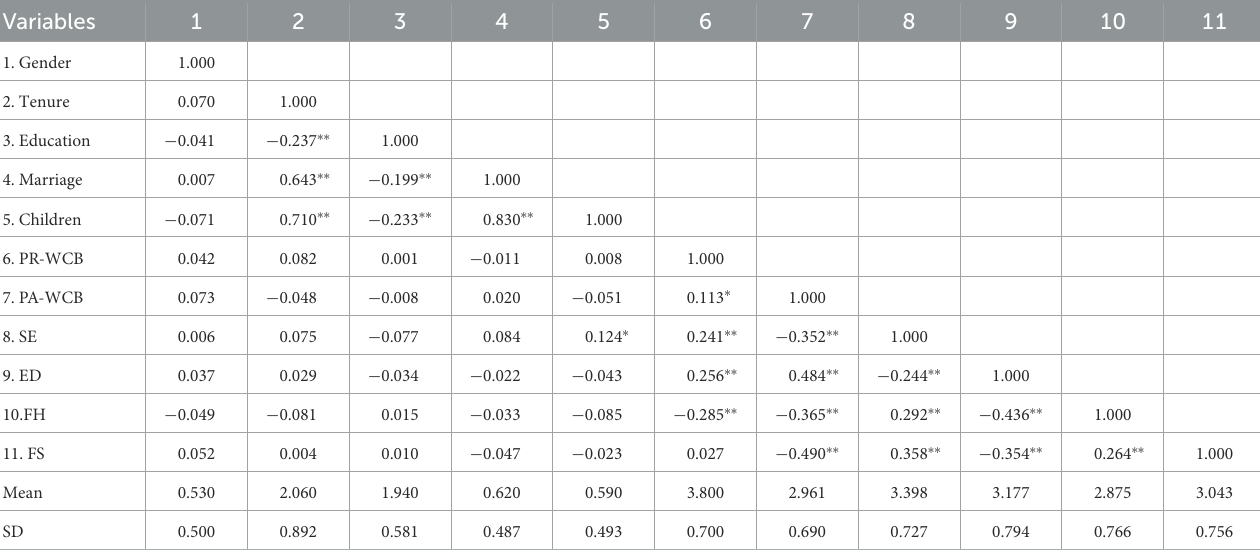
TABLE 4 Means, standard deviations and correlations among variables.